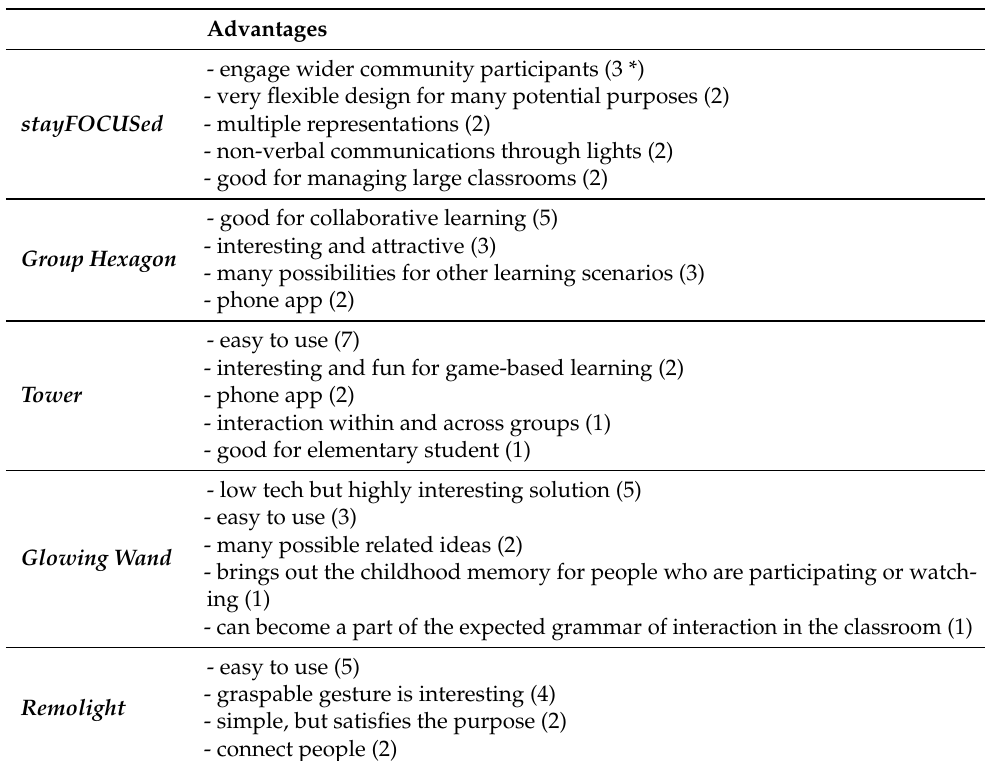
Table 5. Educational experts’ feedback on the advantages of this study’s developed tangible tools (* number of comments